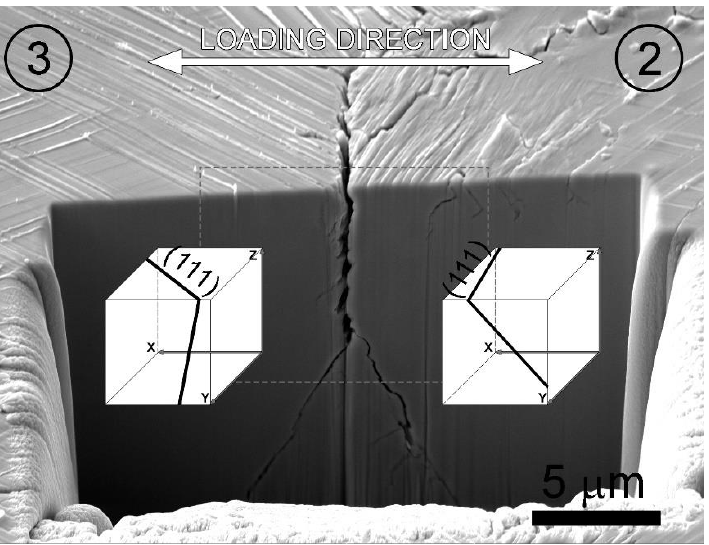
Figure 23. Cracked grain boundary in fatigued Sanicro 25 stainless steel. Surface relief and FIB cut showing orientation of PSBs, PSMs and cracks.